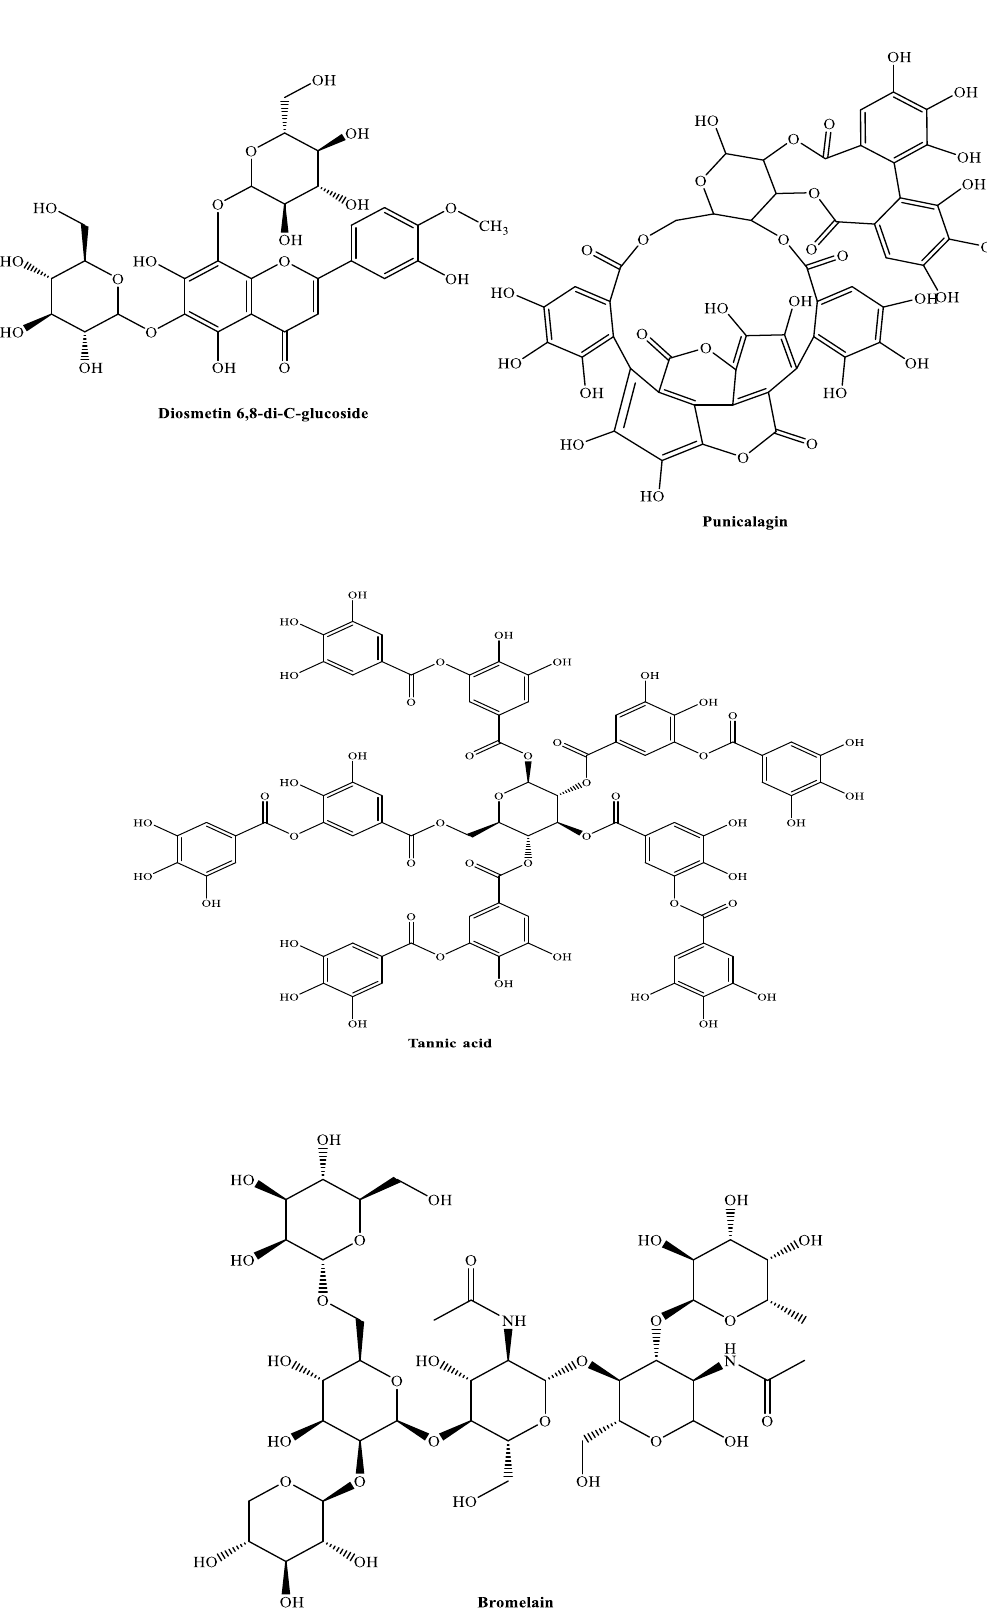
Figure 2. Various types of antibacterial polyphenols present in fruits.